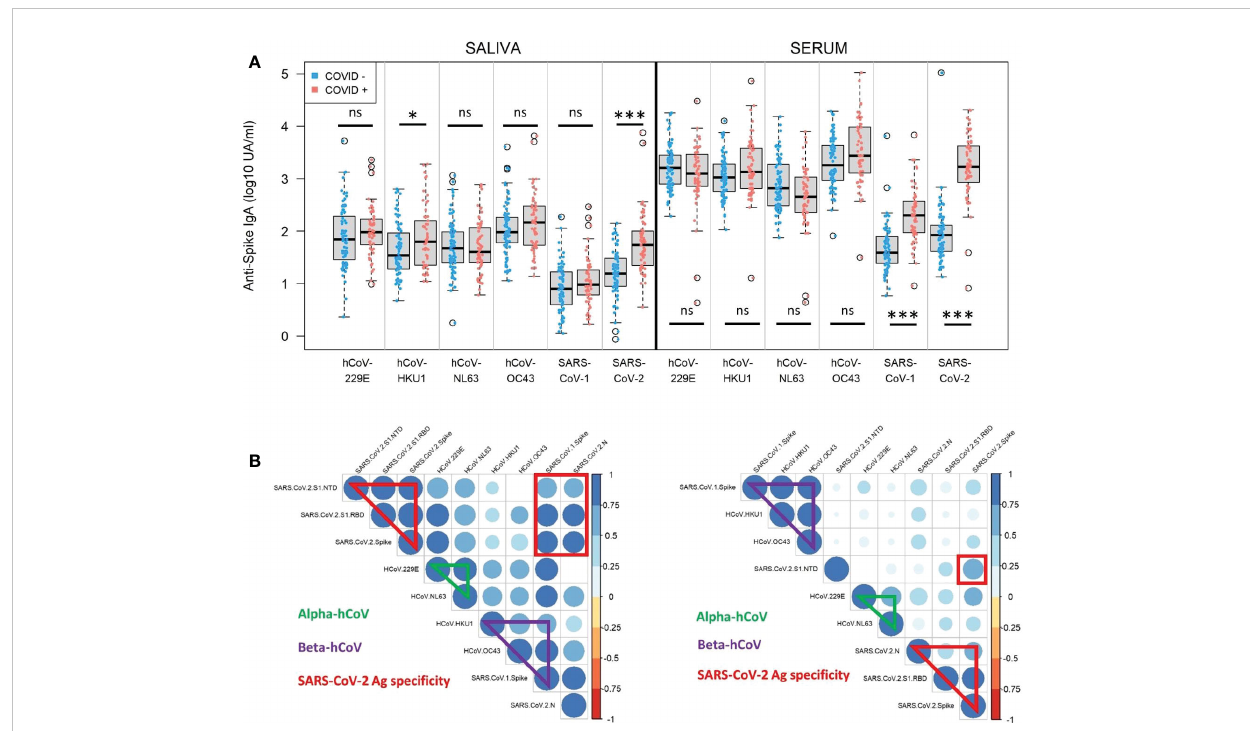
FIGURE 4 Serum and saliva anti-Spike IgA titers against human coronaviruses. (A) Normalized log-10 transformed serology titers of anti-Spike IgA (log10 UA/ ml) in saliva (left) and serum (right) from naive (COVID-, blue) and previously infected (COVID+, red) individuals measured by MSD technology at enrollment (V1). IgA speci fi city corresponds to the Spike proteins from human coronaviruses (hCoV) 229E, HKU1, NL63, OC43, SARS-CoV-1 and SARS-CoV-2. Kruskal-Wallis test: ns, not signi fi cant; * p<0.05; *** p<0.001. (B) Correlation matrices in saliva (left) and serum (right) at V1 showing signi fi cant positive correlations between alpha-coronaviruses (hCoV 229E and NL63), beta-coronaviruses (hCoV OC43, HKU1, SARS-CoV-1, SARS- CoV-2), as well as SARS-CoV-2 antigen speci fi city (N, Spike, Spike/RBD, Spike/NTD) in previously infected individuals. Only signi fi cant correlations (Spearman, p<0.05) are represented on the matrices. The color and size of the dots (scale next to the graph) indicate the degree of correlation (Spearman, rho) between the different parameters (small to large indicating low to high